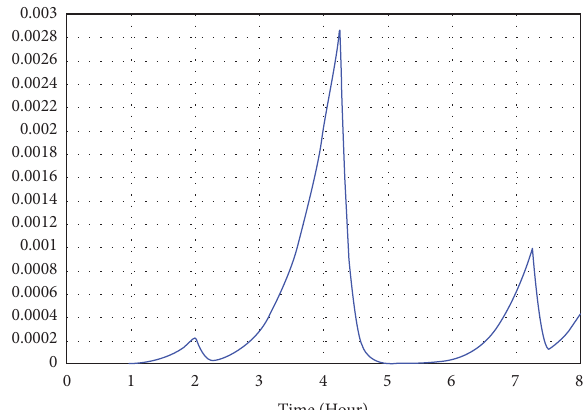
Figure 5: HEP based on the stress of workers when the stress relief rate is